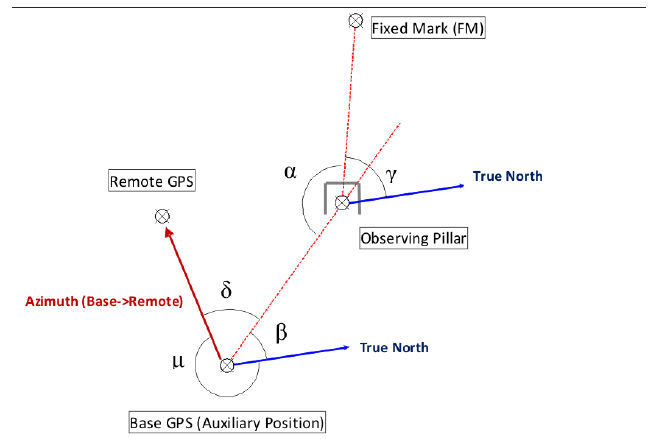
Figure 5. Fixed mark measurement using base GPS station on auxiliary